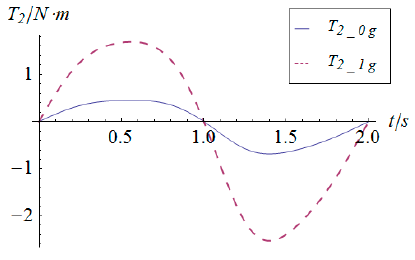
Figure 16. Torque vs. time of actuator 1.